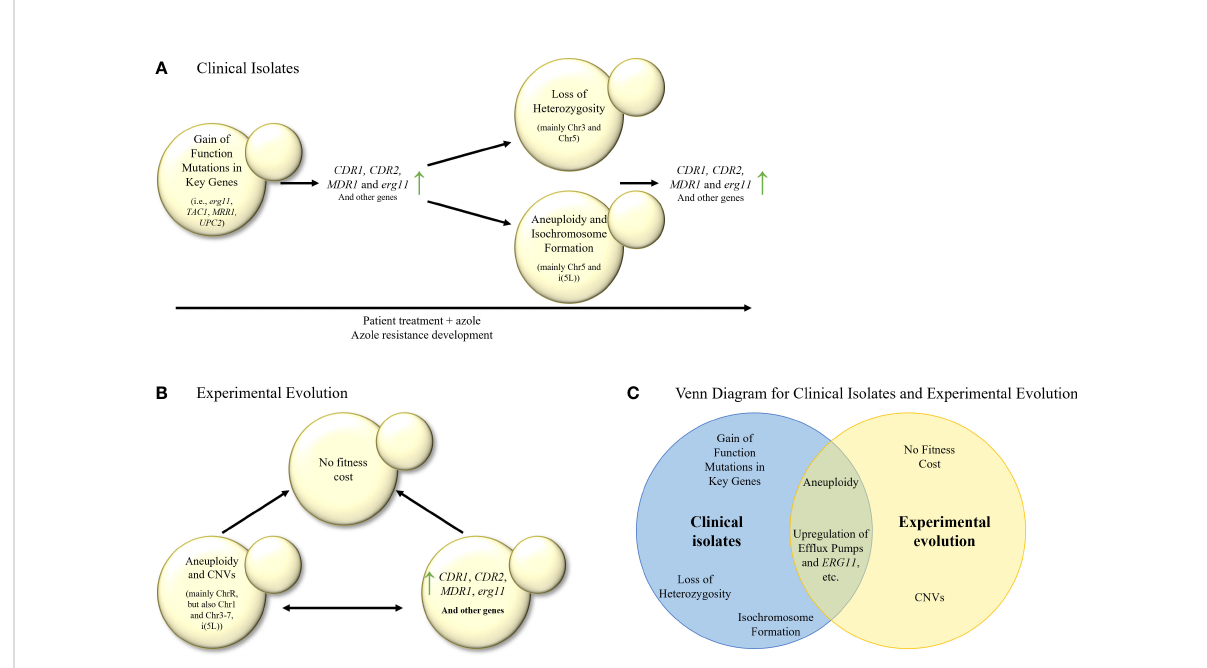
FIGURE 2 (A) Stepwise evolution of triazole resistance in serial clinical isolates of C. albicans . Gain – of – function mutations are followed by elevation in the expression of ef fl ux transporters and ergosterol biosynthesis (erg) genes, then by LOH, aneuploidy and isochromosome formation, and fi nally by another increase in expression of ef fl ux transporters and erg genes, leading to triazole resistance. (B) In – vitro evolution of triazole resistance in C. albicans isolates. Elevation in the expression of ef fl ux transporters, erg genes and many other genes is commonly observed, as well as aneuploidies and CNVs in most of the chromosomes. It is unknown whether overexpression of key genes precedes aneuploidies and CNVs, or vice versa. Usually, no fi tness cost was found in the evolved isolates. (C) Venn diagram of azole resistance mechanisms in serial clinical isolates and in in – vitro evolution in C. albicans isolates. Aneuploidy and upregulation of ef fl ux pumps and ERG11 are common to both evolutionary